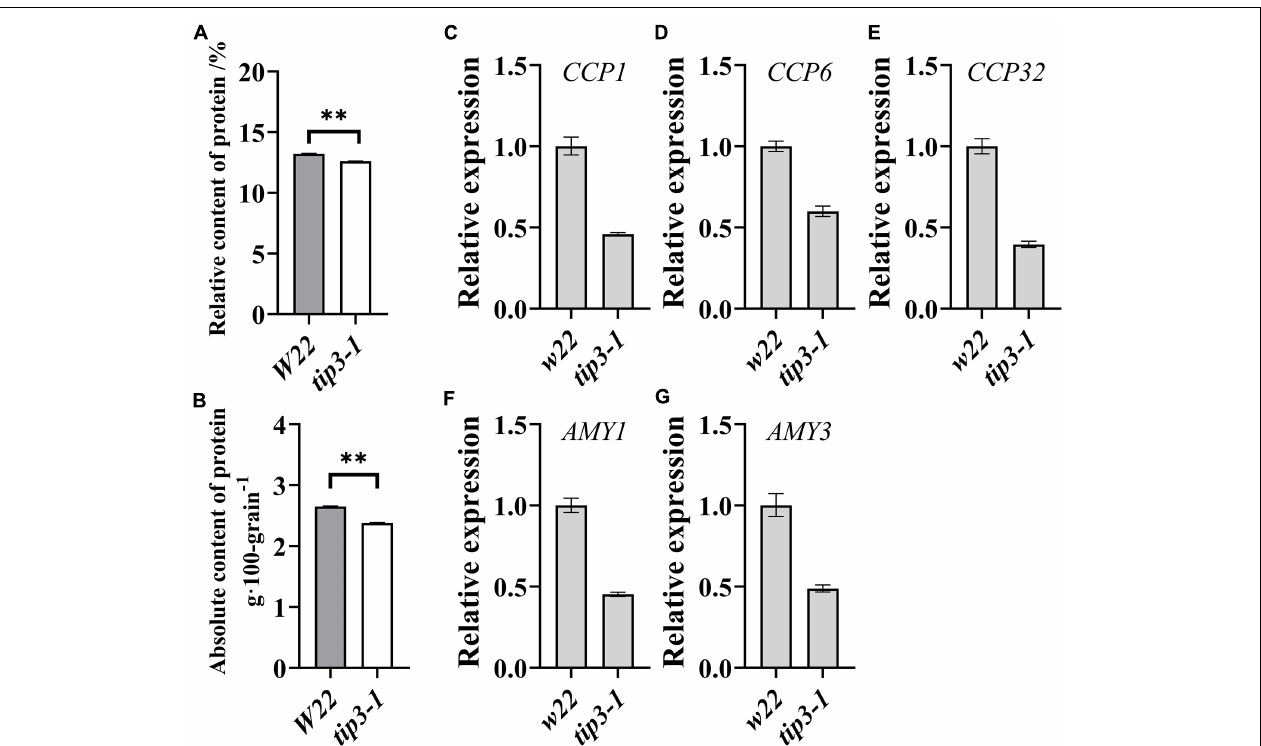
FIGURE 6 | Protein content and mobilization-related genes expression in seeds. Determination of the relative protein content (A) and the absolute protein content per 100 grains (B) in tip3-1 mutants and W22 . All the seeds were harvested at maturity. We multiplied the relative content of the components by the 100-grain weight to calculate the absolute content of the components (g · 100 grain − 1 ). Data are means ± SD ( n = 3). qRT-PCR analysis of the expression levels of mobilization-related genes of cysteine protease1 (CCP1, C ), cysteine protease 6 (CCP6, D ), cysteine protease 32 (CCP32, E ), alpha amylase 1 (AMY1, F ), alpha amylase 3 (AMY3, G ) . The samples were collected at 36 h after imbibition. ACTIN 1 was used as an internal control. Data are means ± SD . ** indicates the significant differences at 1% level, according to Student’s t -test, ns indicates